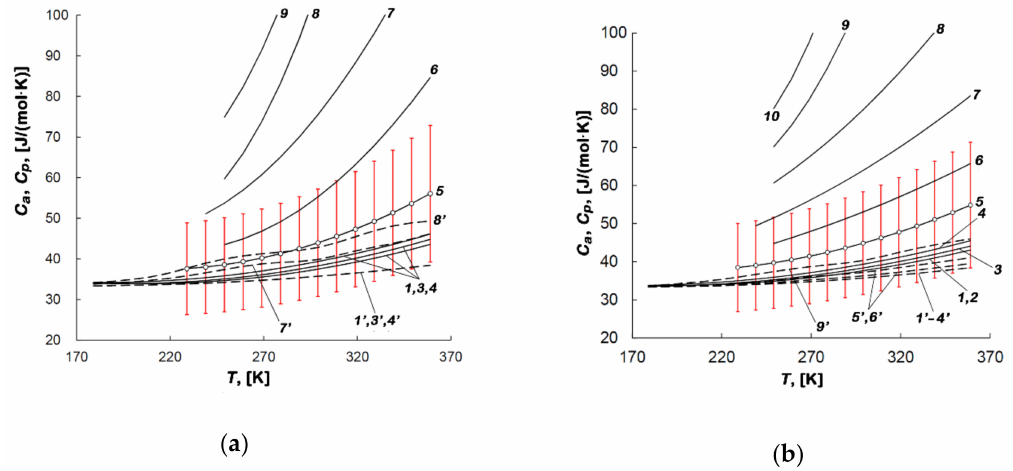
Figure 10. Temperature dependences of the di ff erential molar isosteric heat capacities of the methane-AC-4 ( a ) and methane-AC-6 ( b ) adsorption systems and the gas phase (numbering with stroke) at the values of methane adsorption, mmol / g: 0.1 ( 1 ), 0.3 ( 2 ), 1.0 ( 3 ), 2.0 ( 4 ), 4.0 ( 5 ), 6.0 ( 6 ), 7.0 ( 7 ), 7.8 ( 8 ), 8.3 ( 9 ). The error bar is